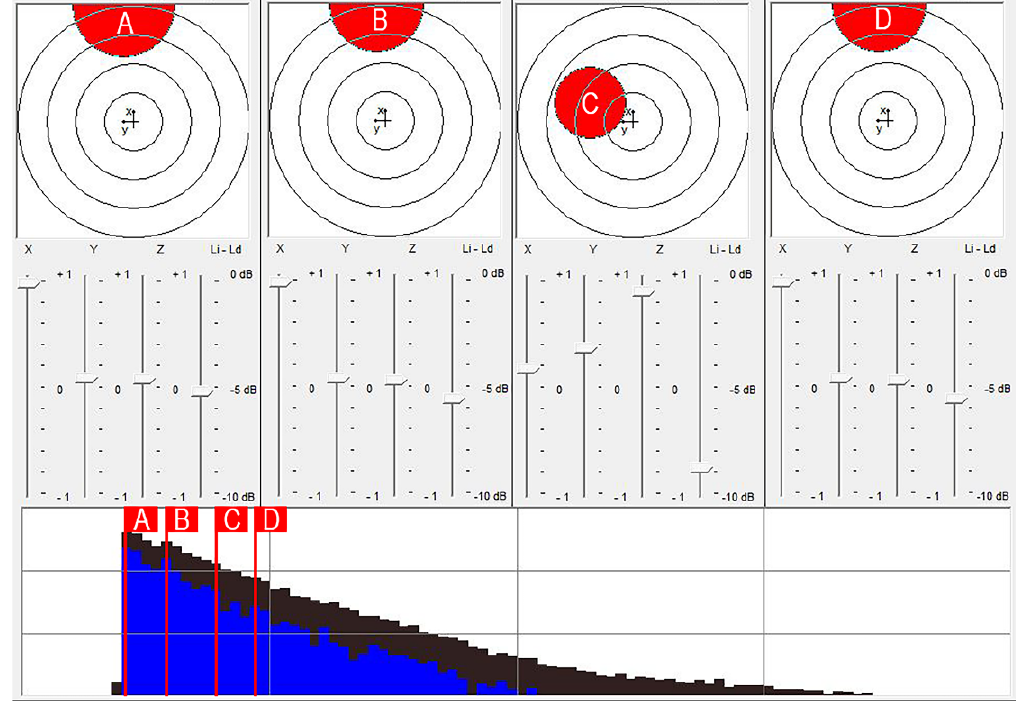
Figure 7. Example of the DOA analysis performed with the IRSpatial software tool. The 1st-order ambisonics impulse response corresponds to the S1-R4 combination in the Bacinete main shelter. Red dots show the DOA and the intensity of each group of reflections (A, B, C or D), the blue bars represent the sound intensity and the black bars the energy density of the signal.